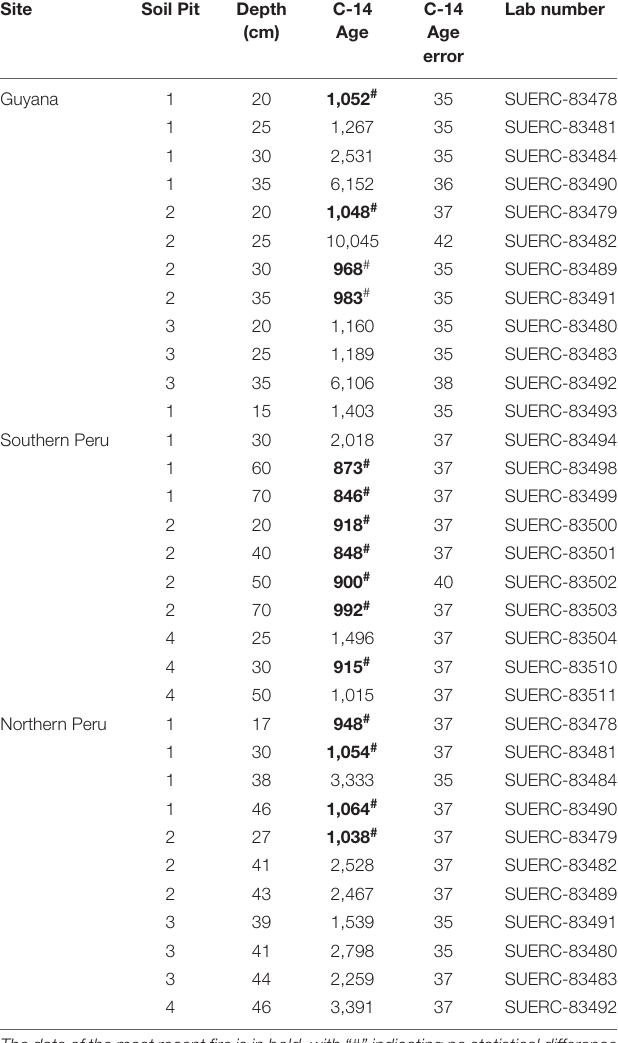
TABLE 1 | Radiocarbon dates for charcoal sampled from terra firme soil in structurally intact forest permanent plots in Guyana, southern Peru, and northern